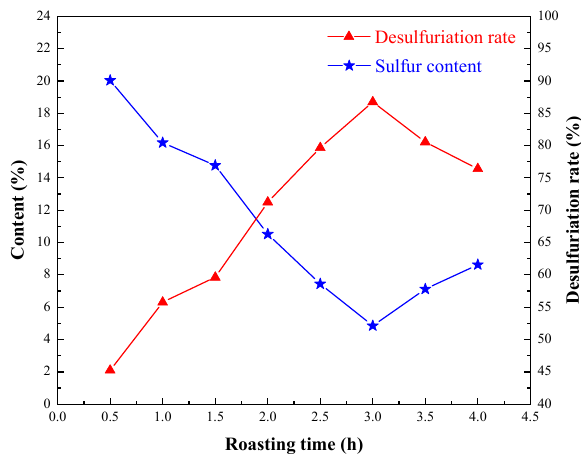
ff ect of oxidizing roasting time on sulfur Figure 4. Effect of oxidizing roasting time on sulfur removal. Figure 4. E